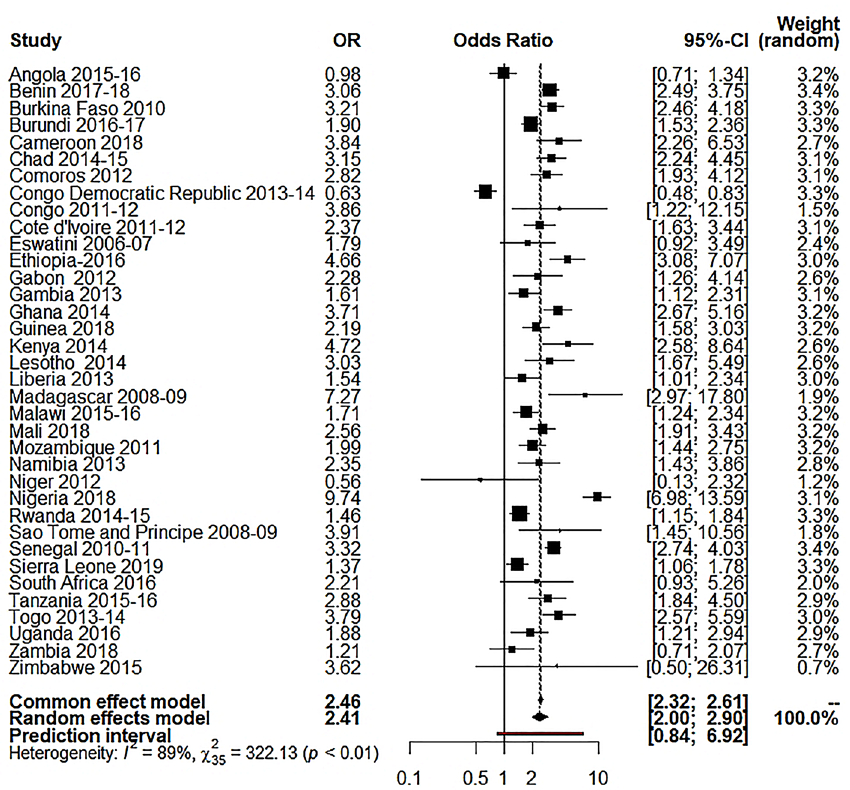
Figure 5. Forest plot for husband’s education.